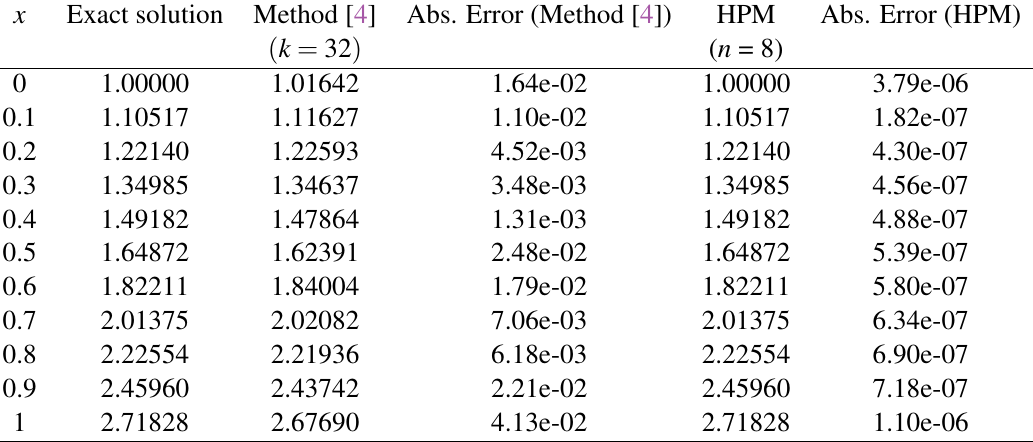
Fig. 1 Error analysis of Example 4. Table 5: Numerical result of Example